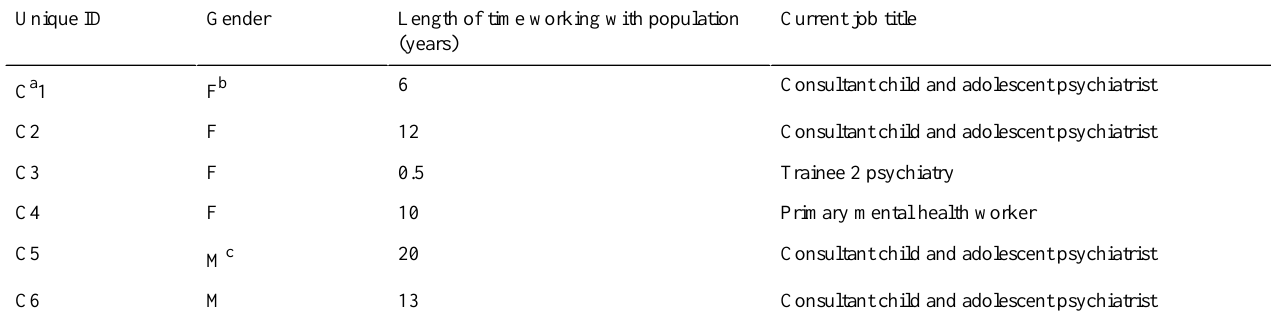
Table 3. Demographic characteristics of clinicians demonstrating a total of more than 57 years of experience working with children and young people with attention-deficit hyperactivity disorder